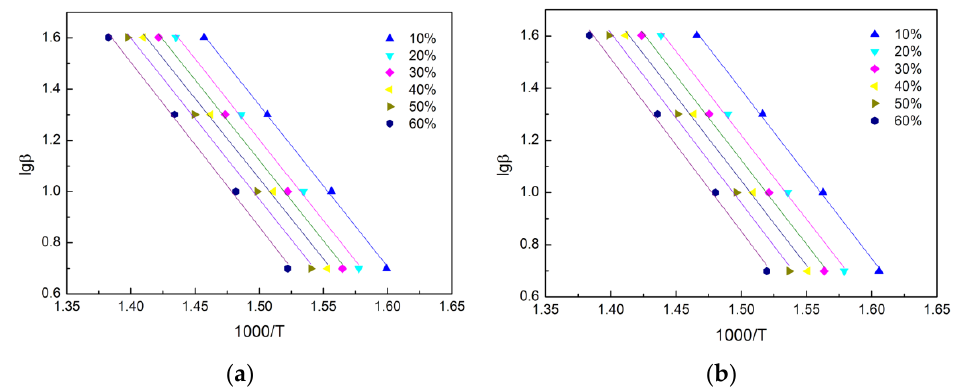
Figure 7. The plots of lg ( β ) vs. 1000/ T of TE ( a ) and FRTE ( b ). The apparent activation energy values of neat TE and FRTE composites were obtained by the Flynn–Wall–Ozawa method in the conversion range of 10–60%. The values of conversion 10%, 20%, 30%, 40%, 50% and 60% were used, and the activation energy values corresponding to the different conversion are listed in Table 3. It was found that the E of neat TE was lower than that of FRTE composites in the conversion range of 10–60%. The average activation of neat TE and FRTE were 114.9 kJ/mol and 118.2 kJ/mol, respectively. Table 3. Activation energies of TE and FRTE degradation by Flynn–Wall–Ozawa method.